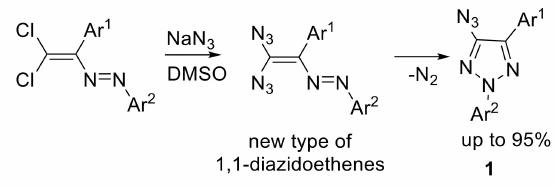
Figure 2. The formation of